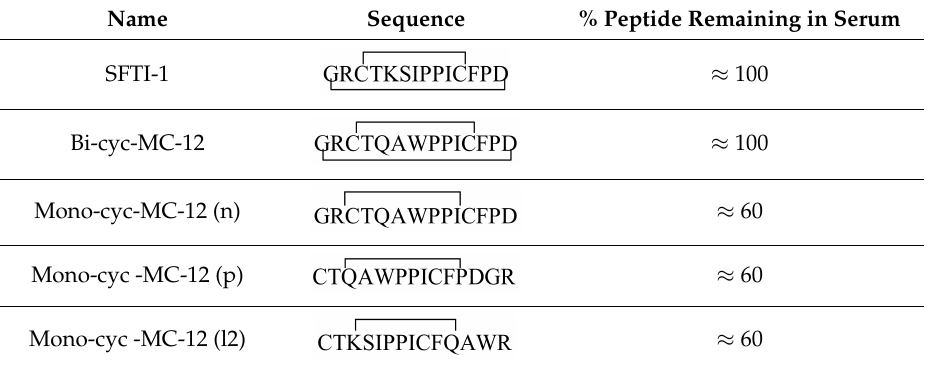
Table 4. Sequences of the grafted MC-12 peptides. The native MC-12 sequence is